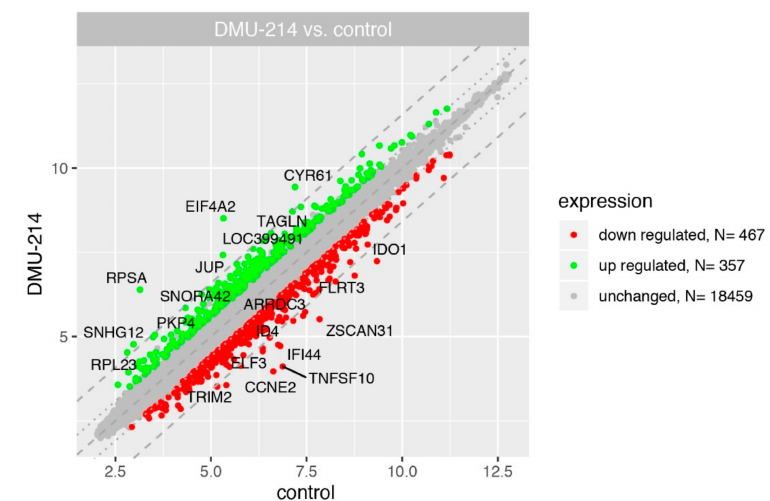
Figure 3. Total gene expression profile of the SKOV-3 cell line after 24 h incubation with DMU-214 (0.125 µ M). Each dot represents a mean value of the single gene expression ( n = 3 / sample). Dotted lines indicate cut-o ff values (1.5-fold change in expression). The grey dots represent the genes below the cut-o ff limit (fold = 1.5 adjusted p -value < 0.05) considered as unchanged ( n = 19228). The green colour marked the stimulated genes ( n = 194) while the red ones inhibited by DMU-214 ( n = 267). Ten genes with the highest and the lowest fold change values were labelled with the appropriate gene symbols.